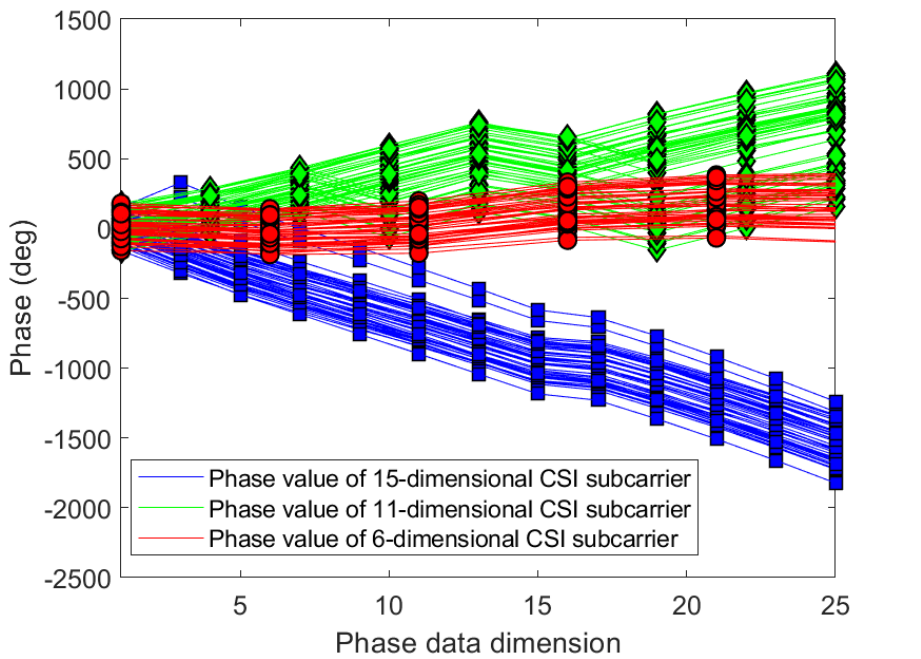
Figure 17. Compare the phases change trends with different dimensions on antenna a at reference point (0,1) of AP1 in the lobby of IT2